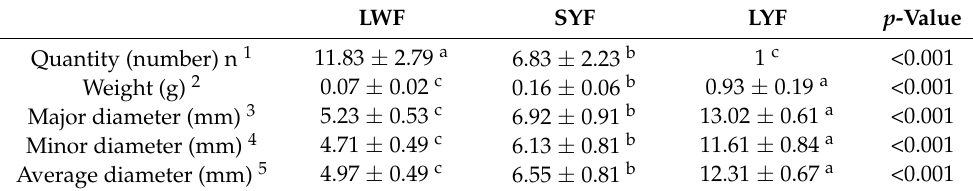
LWF = large white follicles; SYF = small yellow follicles; LYF = large yellow follicle. 1 Numbers of follicles around follicle selection, including LWF, SYF, and LYF. 2 Weight of LWF, SYF, and LYF. 3,4,5 Maximum, minimum, and average diameters of follicles, respectively. The values in the table are compared within each row, and different letters indicate significant difference ( p < 0.05).